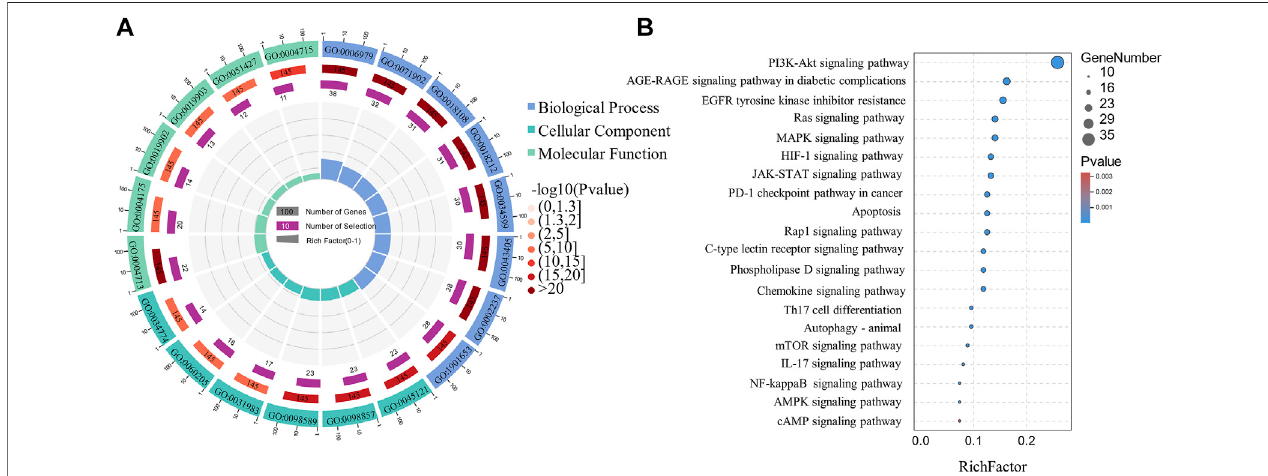
FIGURE 8 | Circle and Bubble charts of GO entries and KEGG pathways. (A) The top 20 signi fi cantly enriched GO terms (B) The top 20 KEGG pathways.